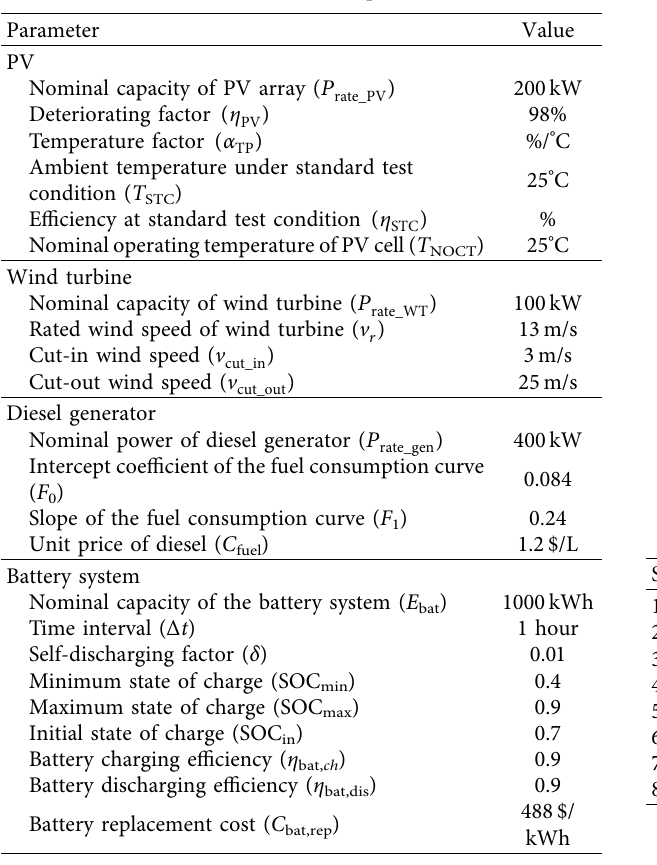
Table 4: Simulation input data.